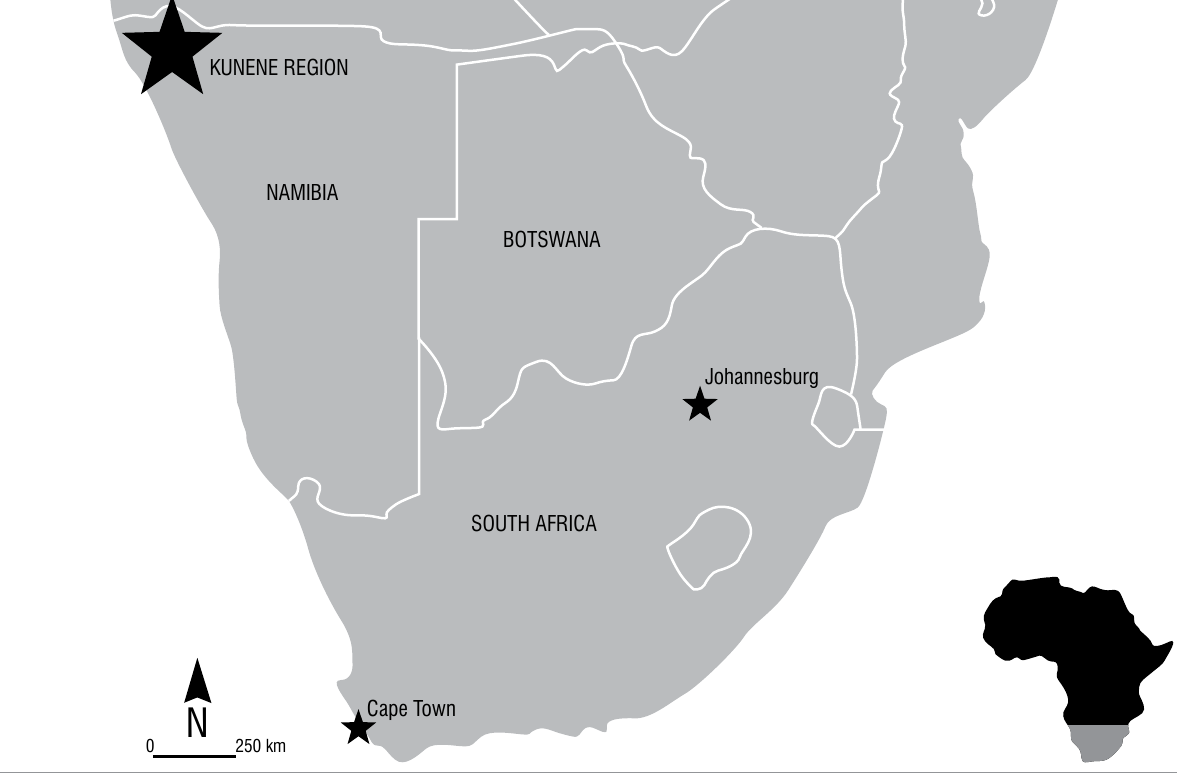
Figure 1: The location of the Kunene Region of northern Namibia within southern Africa.